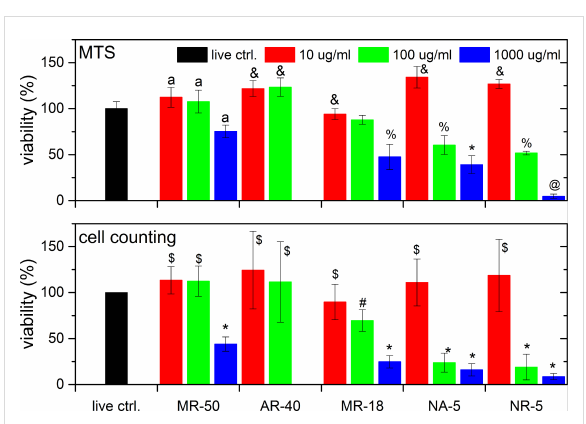
Figure 4: Viability of SAOS-2 cells incubated with NDs for three con- centrations as a function of ND type and surface treatment after 7 days. (Upper row) results of the MTS assay; (lower row) results of cell counting after nuclei staining. The results are given as the mean ± SD from 3 experiments, each performed in sextuplicate. ANOVA, Tukey HSD post-hoc test. “a” - significant difference from NA-5 1000 µg/mL and NR-5 1000 µg/mL p < 0.01, “&” - significant difference from MR-18 1000 µg/mL, NA-5 100 and 1000 µg/mL, NR-5 100 and 1000 µg/mL ( p < 0.05), “%” - significant difference from AR-40, MR-18 10 µg/mL, NA-5 10 µg/mL and NR-5 10 µg/mL ( p < 0.05), “*” - significant difference from control, all 10 µg/mL mea- surements and all MR and AR 100 µg/mL measurements ( p < 0.01), @ - same as “*” + MR-50 1000 µg/mL ( p < 0.01), “$” - significant differ- ence from 1000 µg/mL ( p < 0.01), “#” - significant difference from all AR-40 and from all 100 and 1000 µg/mL concentrations, with the exception of MR-50 ( p < 0.05).